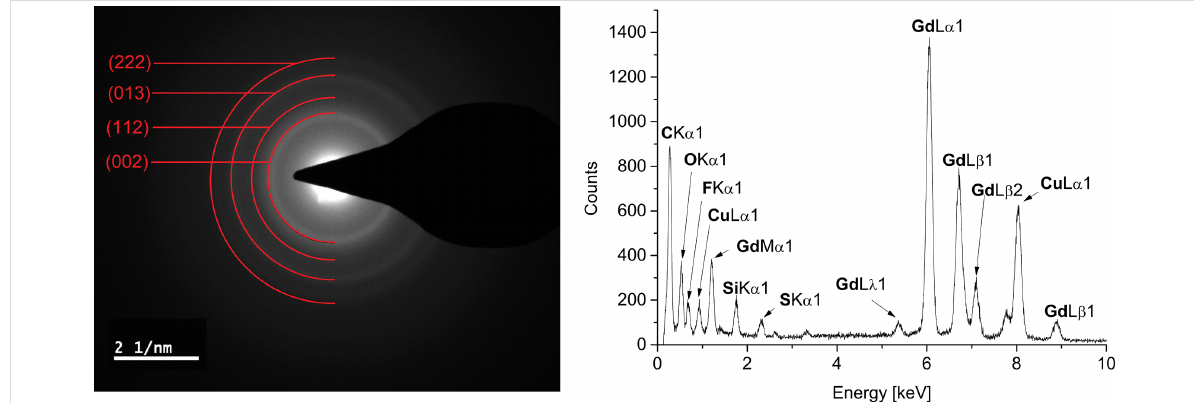
Figure 7: SAED (Gd reference peaks in red from COD 1522526, cubic crystal system with space group Im − 3 m ) and EDX of 1.0 wt % Gd-NPs in [BMIm][NTf 2 ] from Gd(amd) 3 .